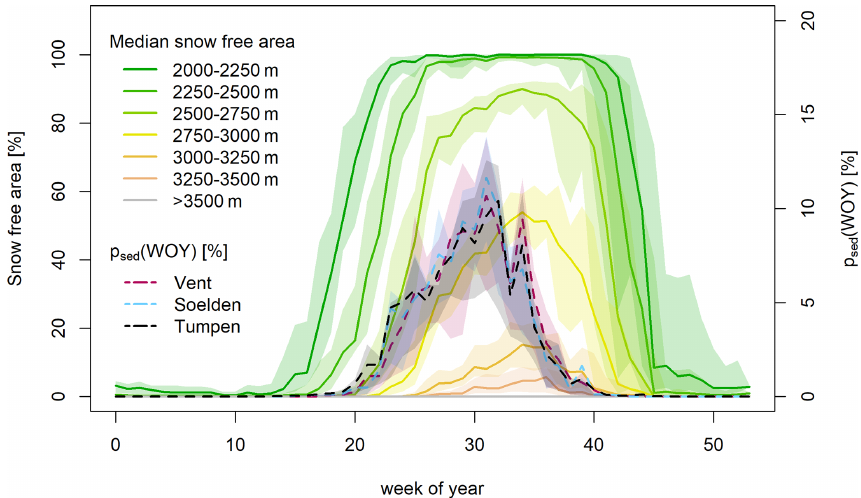
Figure 8. Mean weekly percentage of annual SSY p sed (WOY) and median snow-free fraction resolved to selected elevation bands (above 2000ma.s.l.) within the Tumpen catchment. Lightly colored areas depict interquartile ranges (i.e., 25% and